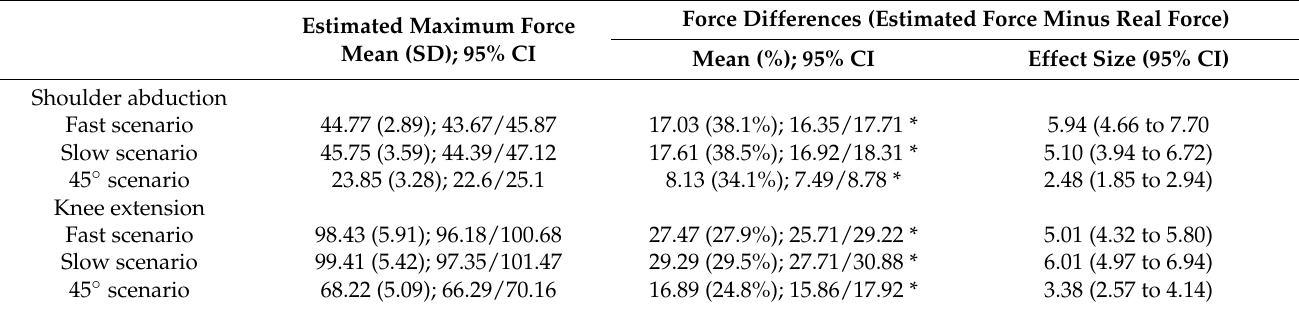
Table 3. Differences between estimated maximum force (Newtons) and real maximum force (Newtons) per exercise and